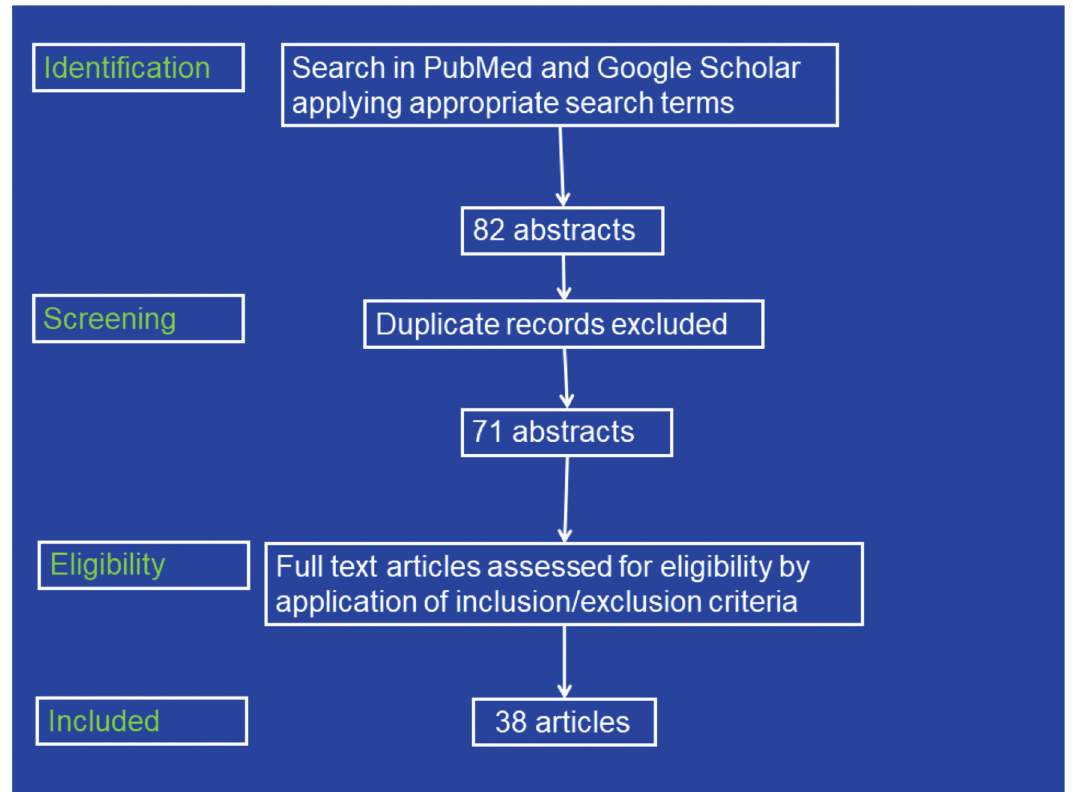
Figure 1 - Flowchart of the study selection